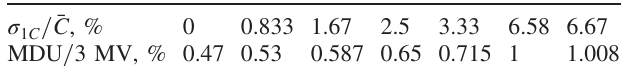
TABLE VII. Flatness of the top of the output pulse of the LTD module consisting of 30 cavities connected in series depending on the tolerance of the capacitor capacitance.